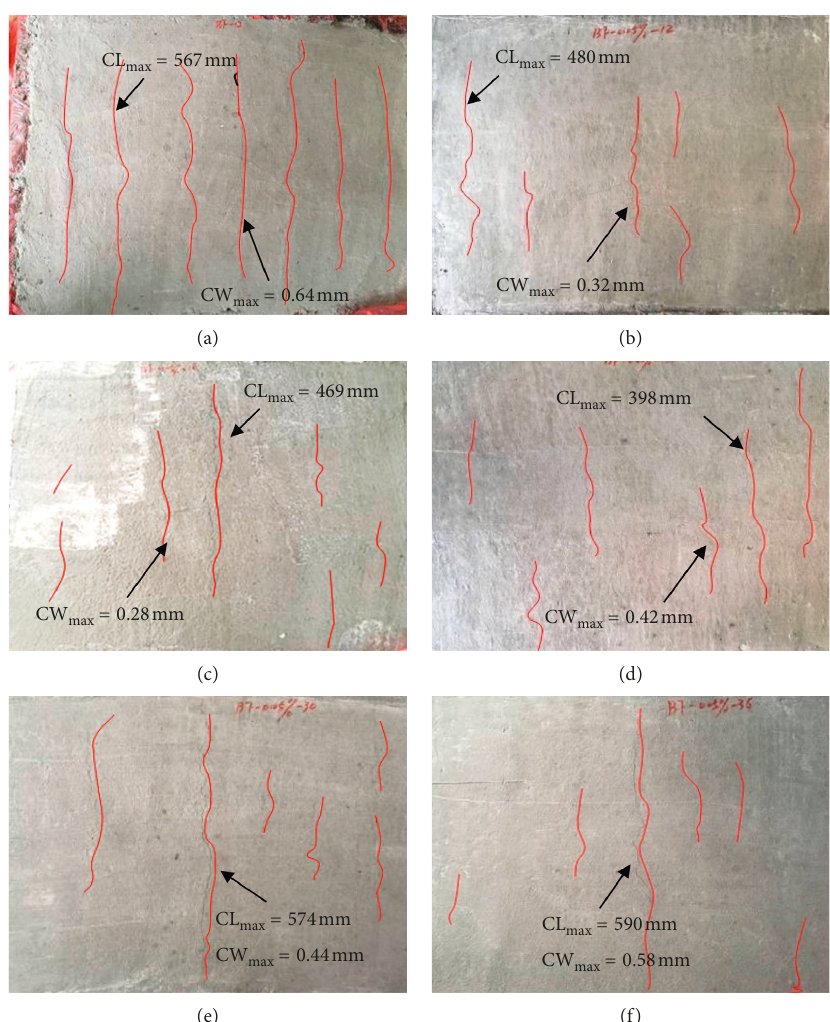
Figure 11: Crack distributions of specimens PC30 and BFRC with different fiber lengths: (a) PC30 ( L � 0mm), (b) BF 30-12-0.05 ( L � 12mm), (c) BF 30-18-0.05 ( L � 18mm), (d) BF 30-24-0.05 ( L � 24mm), (e) BF 30-30-0.05 ( L � 30mm), and (f) BF 30-36-0.05 ( L �